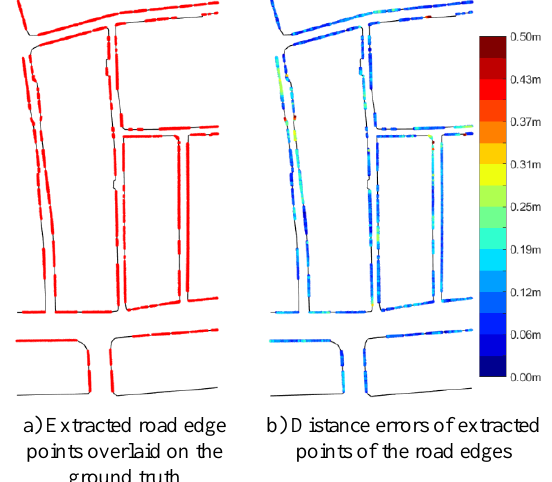
Figure 6. Distance errors of extracted points of the road edges